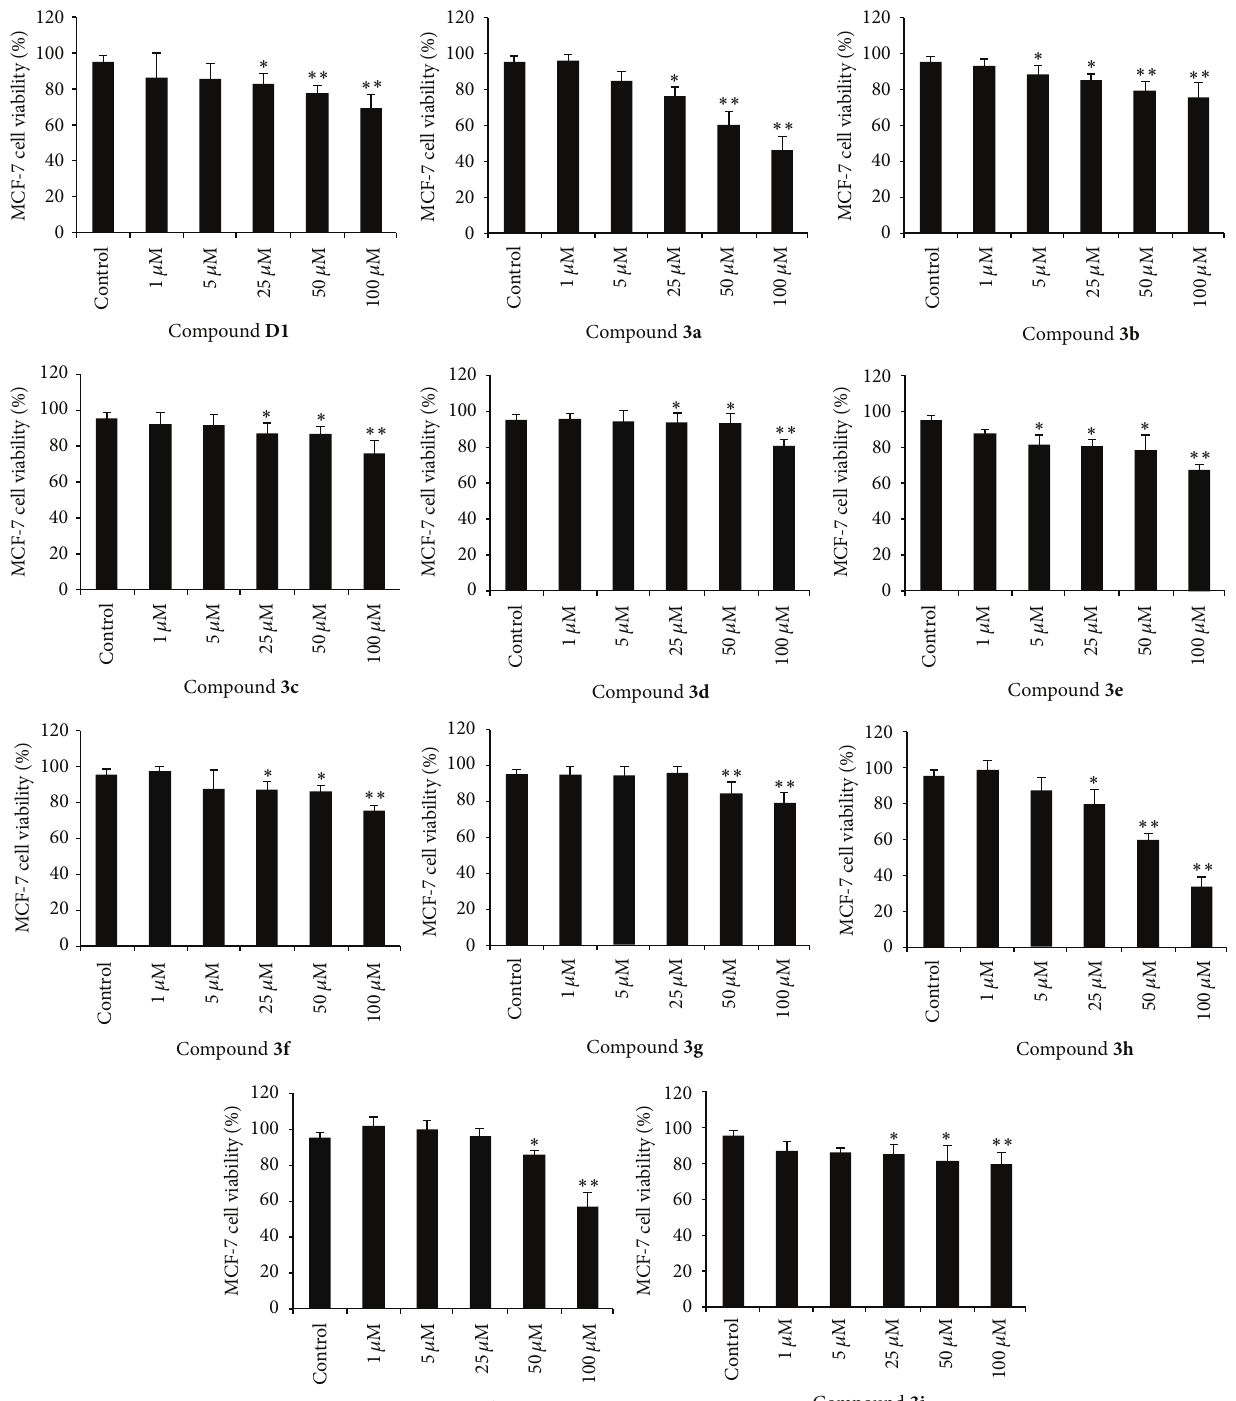
Figure 1: The relative cell viability (%) of MCF-7 cells following the exposure of various concentrations of all the compounds ( D1 and 3a – j ) and untreated control cell for 24 h ( ∗ 𝑝 < 0.05 ; ∗∗ 𝑝 < 0.001